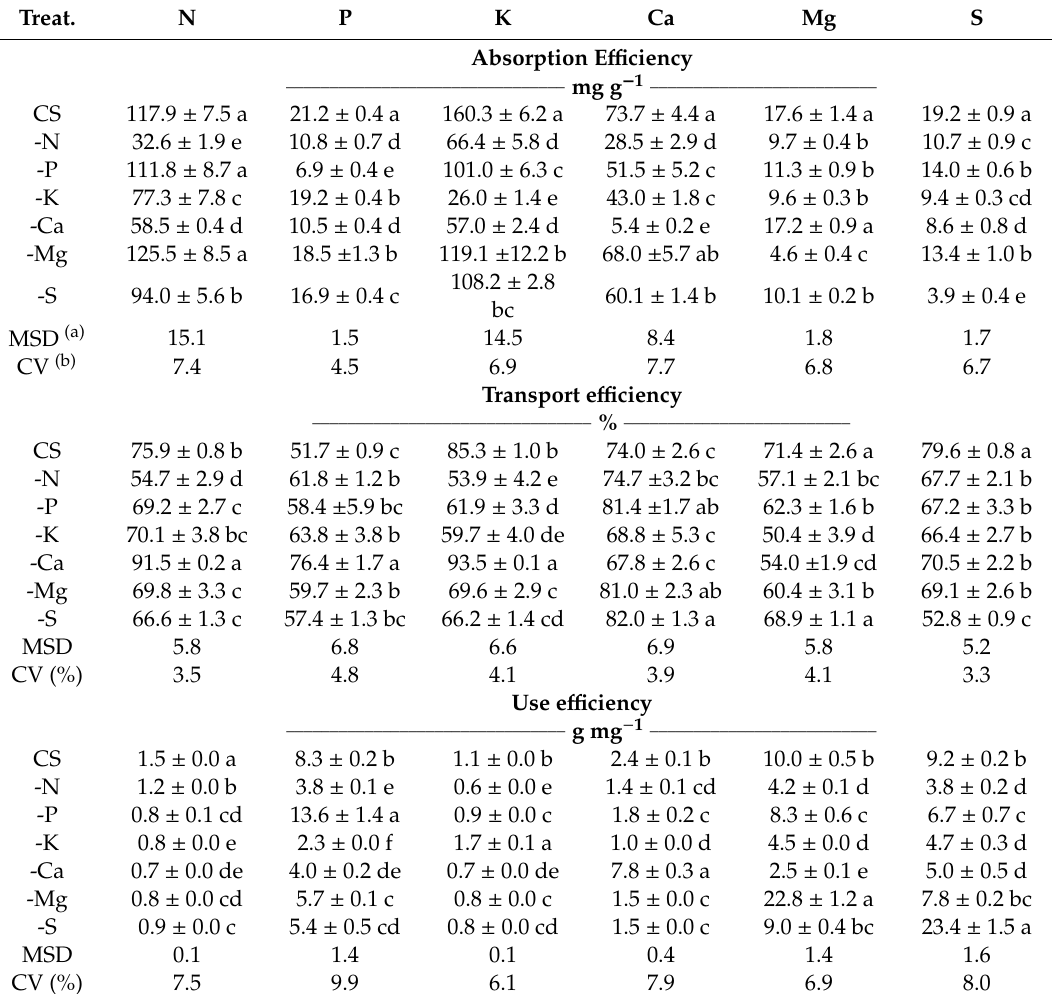
Table 5. Absorption, transport and use e ffi ciency of macronutrients in broccoli ( Brassica oleracea var. italica L.) plants cultivated with a complete nutrient solution (CS) and under macronutrient omission.